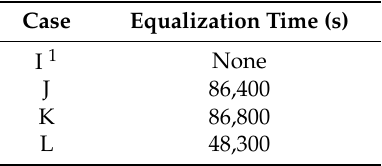
Figure 9. Simulation results of static equalization. ( a ) Case J: SOC of C 0 = 36%; ( b ) Case K: SOC of C 0 = 52%; and ( c ) Case L: SOC of C 0 = 68%. Table 5. Equalization time comparison.